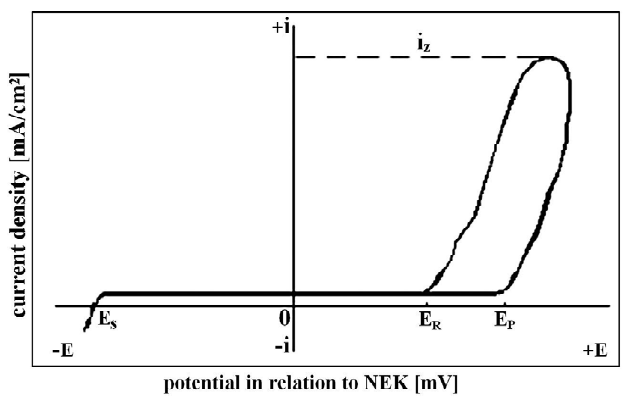
Figure 1. Scheme of the anodic cyclic polarization curves